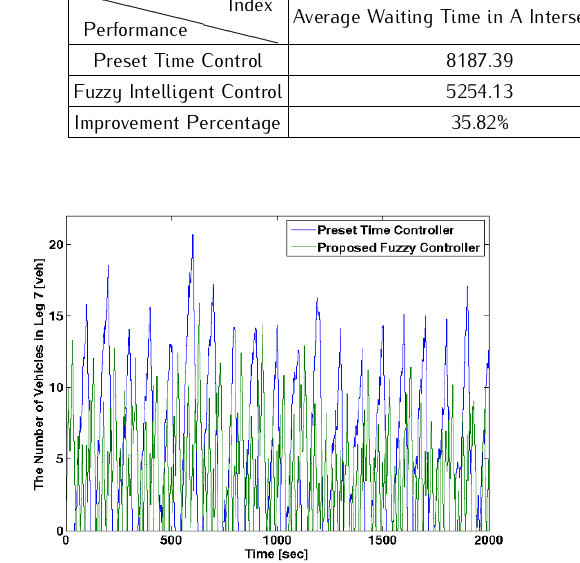
Table 4. The compare of Result Average Waiting Time in four Leg (cid:88)(cid:88)(cid:88)(cid:88)(cid:88)(cid:88)(cid:88)(cid:88) Performance